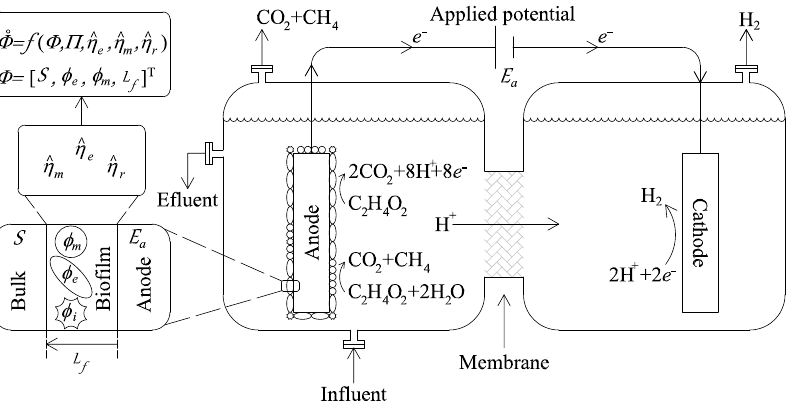
Figure 5. Biofilm schematic representation of the microbial electrolysis cell including effectiveness